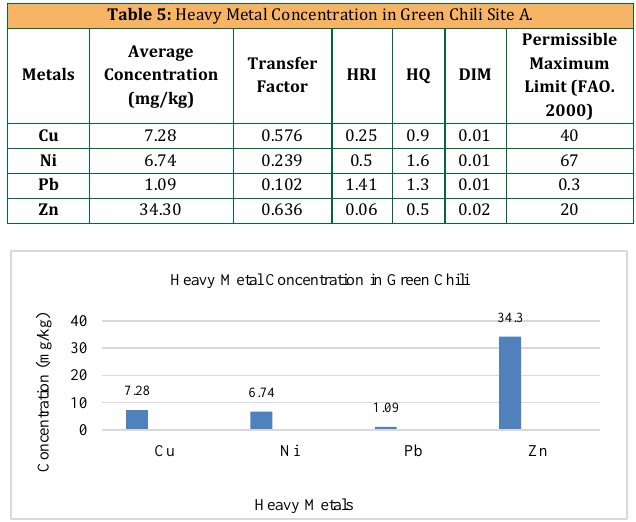
Figure 2: Average concentration of heavy metals in Green Chili at Site A